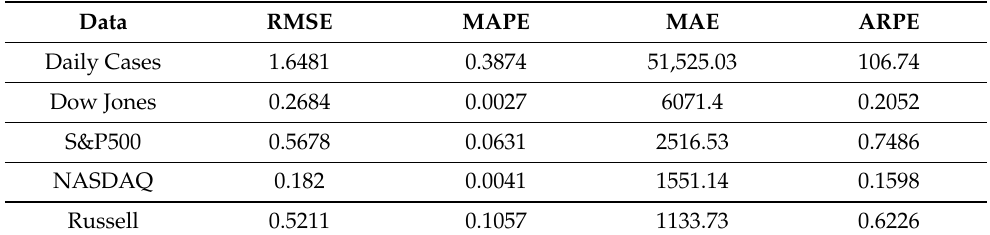
Table 12. Results from system of Γ ( a , b ) OU model. The results reported are the best results from modeling a combination of U.S.A. COVID-19 cases with the stock market data.